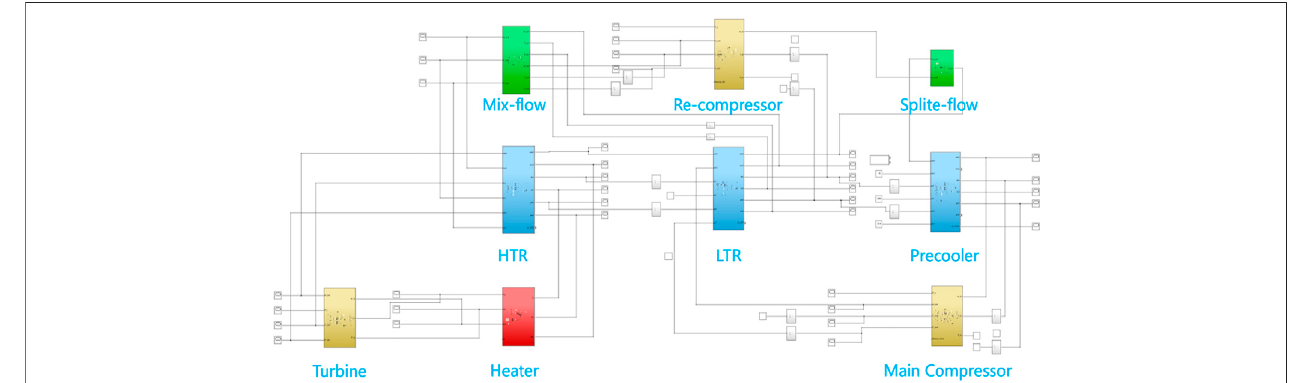
FIGURE 2 | Simulation model of SCO 2 recompression Brayton cycle system.